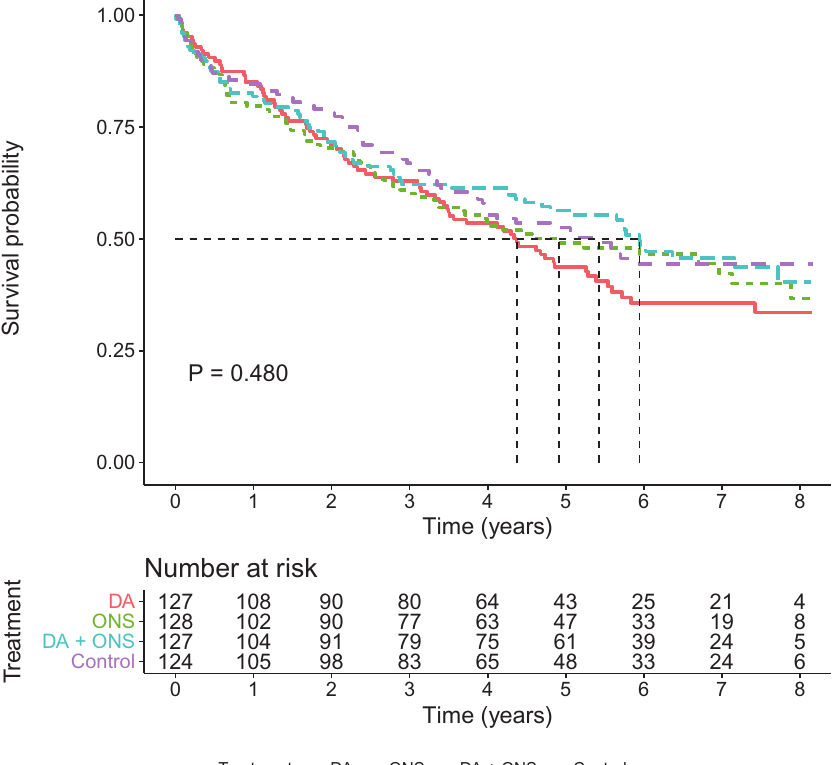
Figure 3. Kaplan – Meier survival curves for participants at risk of malnutrition in the four intervention groups ( n ¼ 506). Log-rank test for any difference between groups ( p ¼ 0.480). DA: dietary advice; ONS: oral nutritional